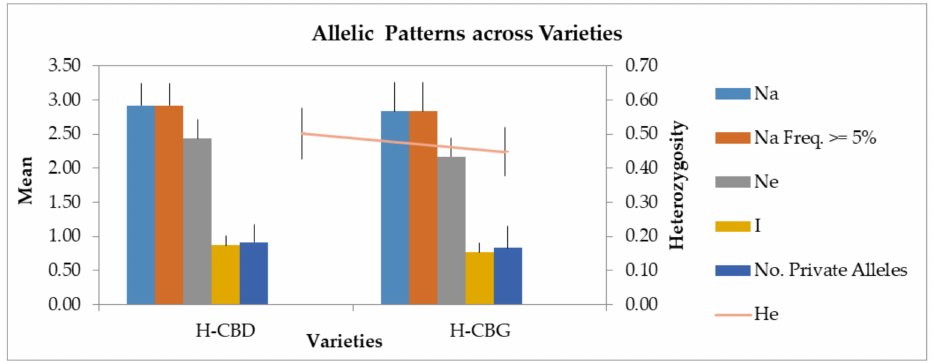
Figure 4. Allelic patterns across the H-CBD and the H-CBG Cannabis varieties (Na Freq ≥ 5% = Number of different alleles with a frequency ≥